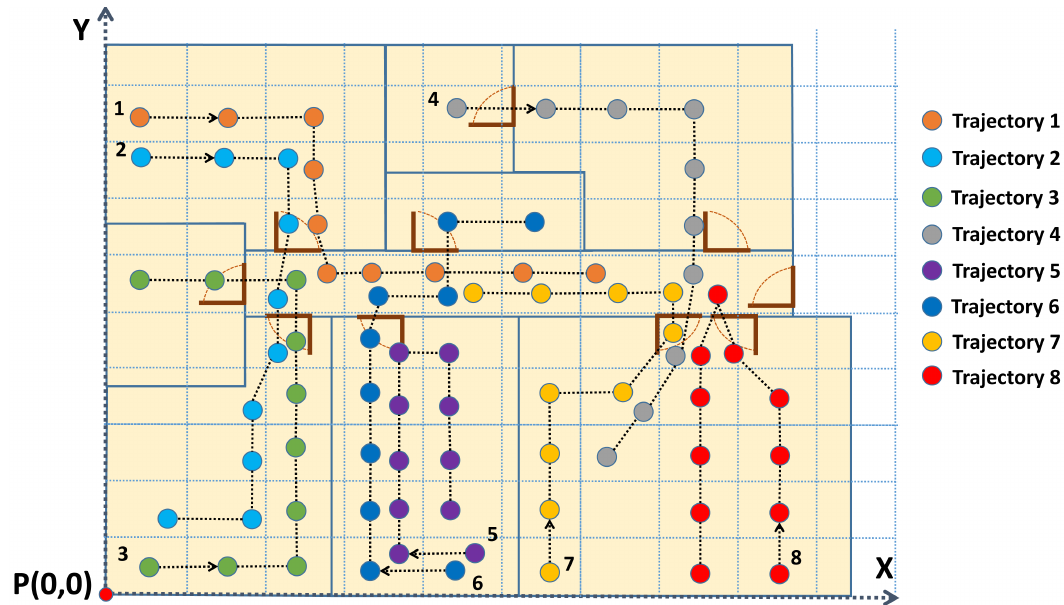
Figure 9. Some of the trajectories followed by